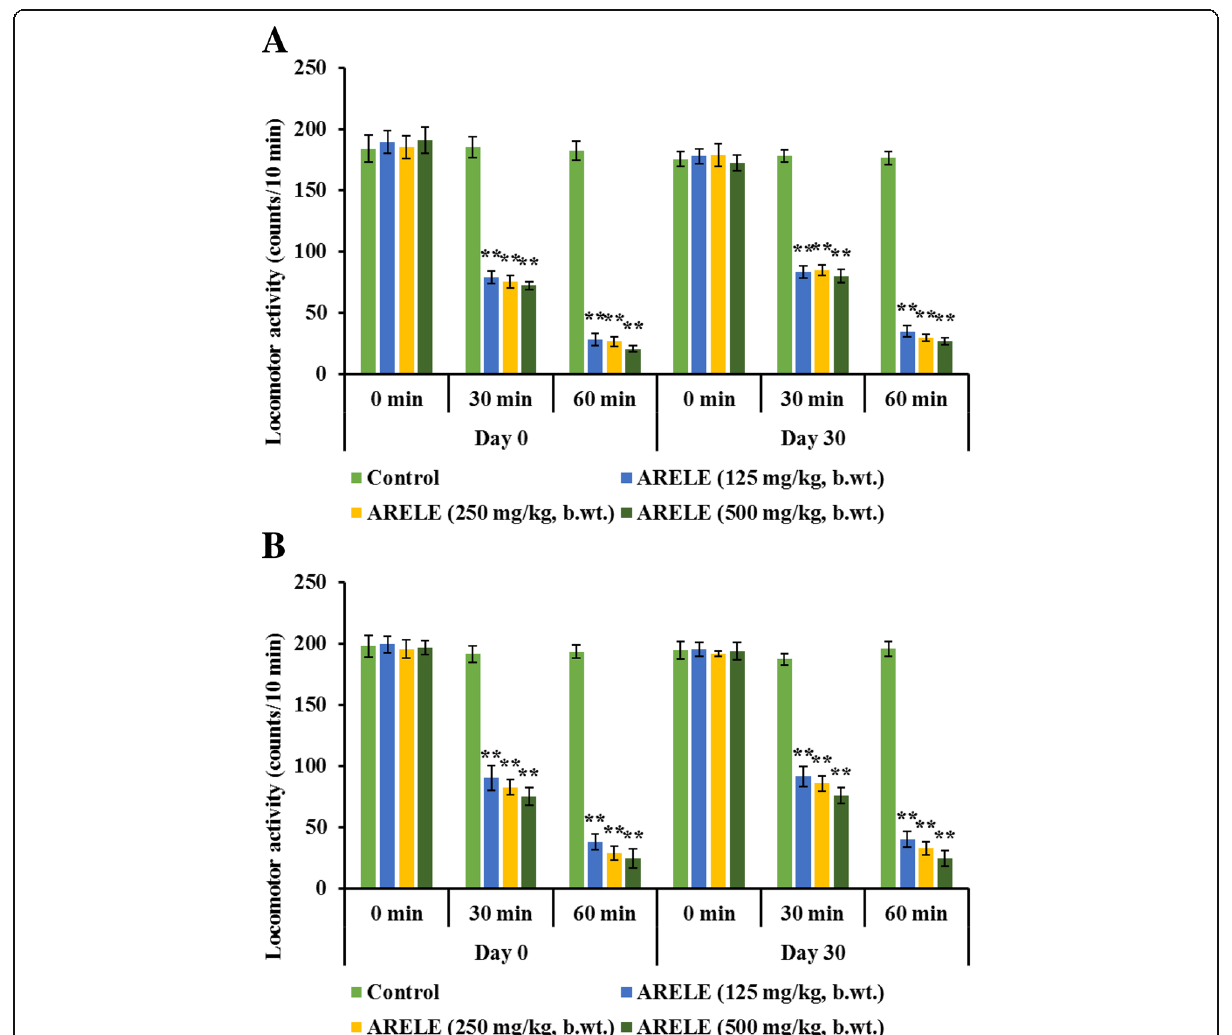
Fig. 5 Locomotor activity of ARELE using Actophotometer method. a Male rats. b Female rats. Values are expressed as mean ± S.D. ( n = 6). Statistical analysis done by one-way ANOVA followed by Dunnet ’ s t-test. ** P < 0.01 compared to control group. * P < 0.05 compared to control